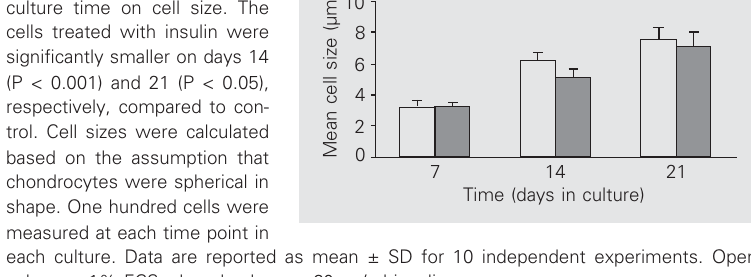
Figure 4. Effect of insulin and 1% FCS on alkaline phosphatase (AP) specific activity in micromass cul- tures of chick embryonic limb mesenchyme. Data are